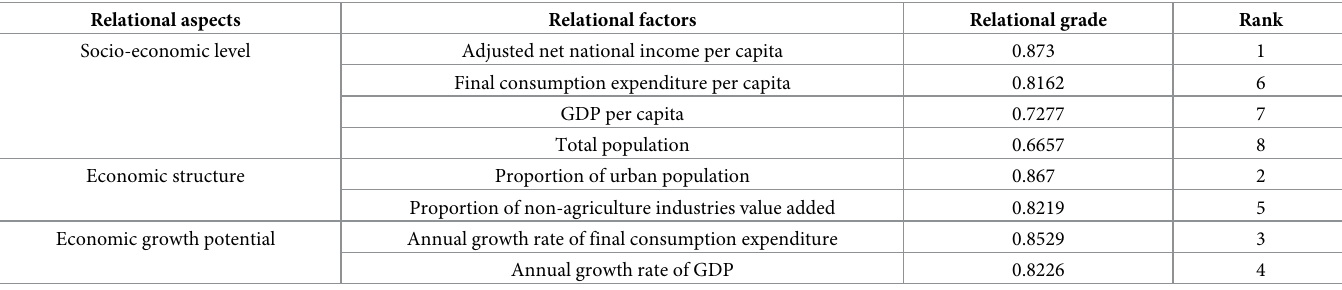
Table 5. Grey relational analysis results of grain demand in